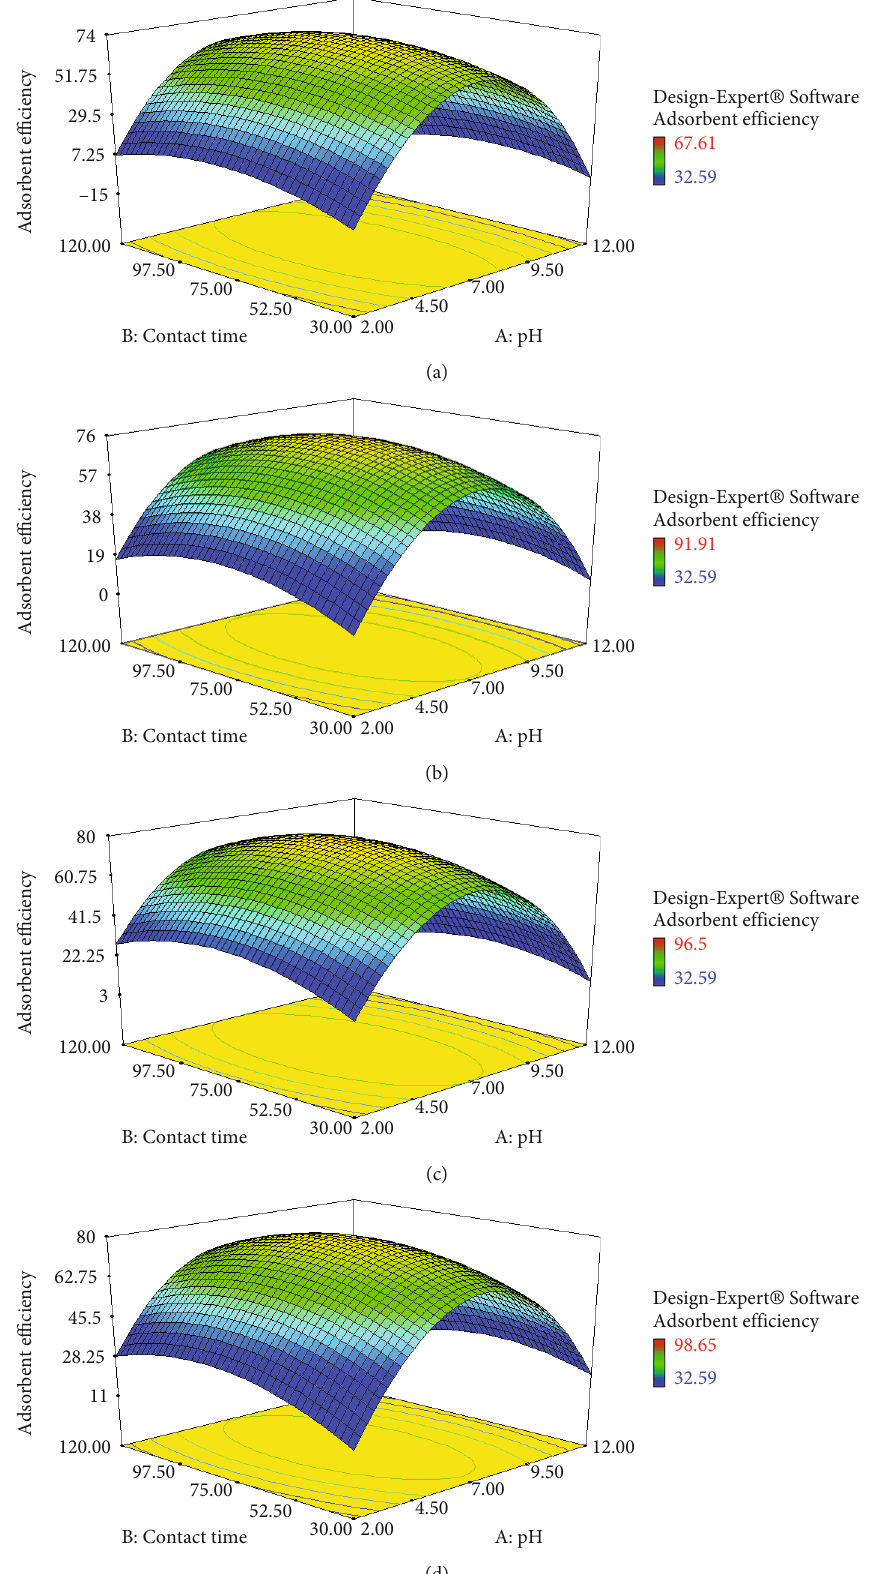
Figure 4: Mutual e ff ect of pH and contact time on the adsorption e ffi ciency of TAADFPs activated at (a) 450 ° C, (b) 500 ° C, (c) 550 ° C, and (d) 600 °